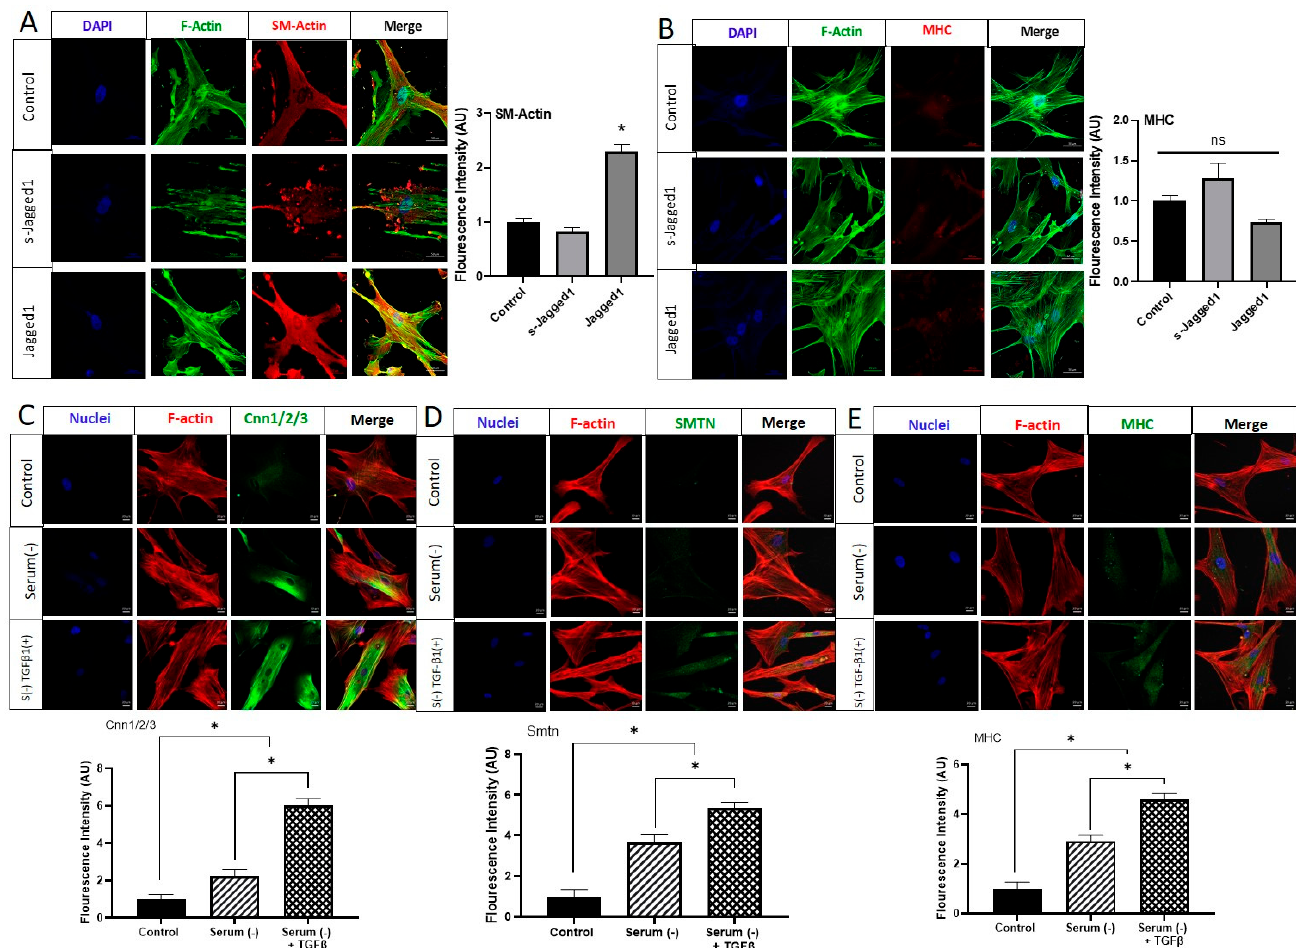
Figure 2. Immunofluorescence microscopy of Jagged1-directed SMC marker protein expression and the effect of serum starvation on late-stage contractile protein expression of HCASMC. Immunofluorescence images comparing the effect of soluble and bead-bound Jagged1 on ( A ) SM-Actin, and ( B ) MHC are shown. Scale bar = 50 µ m. The bar graphs shown to the right of Figures A and B are the corresponding integrated density fluorescence quantification presented as mean ± SD ( n = 5). The control cells in Figures A and B are HCASMCs cultured in SmGM-2. Immunofluorescence staining for the effect of serum starvation and TGF β 1 (2 ng/mL) on the SM-specific protein expression of ( C ) Cnn1/2/3, ( D ) SMTN, and ( E ) MHC. Scale bar = 20 µ m. The bar graphs below are the corresponding integrated density fluorescent quantifications presented as mean ± SD ( n = 15). The control cells are HCASMCs cultured in DMEM supplemented with 5% serum. * indicates significance at p < 0.05, ns indicates no statistical significance.